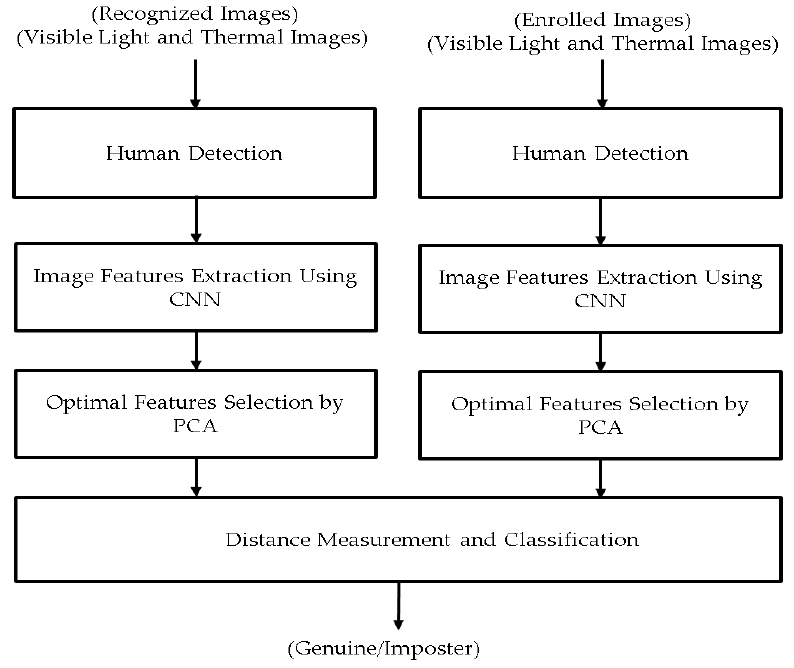
Figure 1. Overall procedure of proposed method for person recognition.